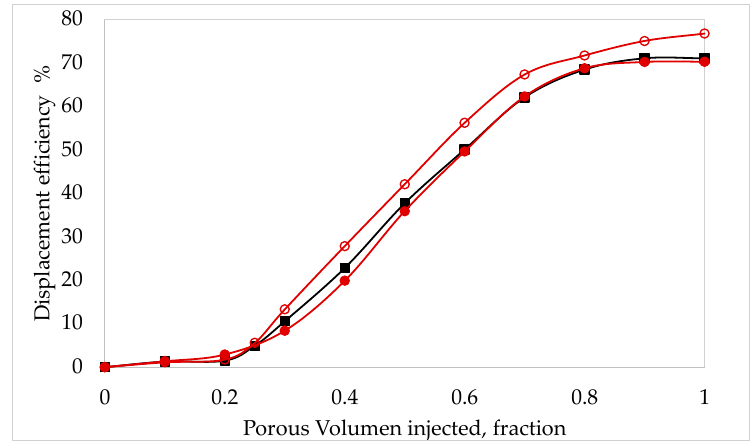
Figure 4. Displacement efficiency (%) as a function of porous volume injected. XG solution (1000 ppm XG, brine 3 % NaCl) (– ● ); HPAM solution (1000 ppm HPAM, brine 3 % NaCl) (– ■); Nanofluid (1000 ppm XG, 300 ppm NP-SiO 2 , brine 3 %NaCl) (– ○ ). Table 2. Core flood experiments.